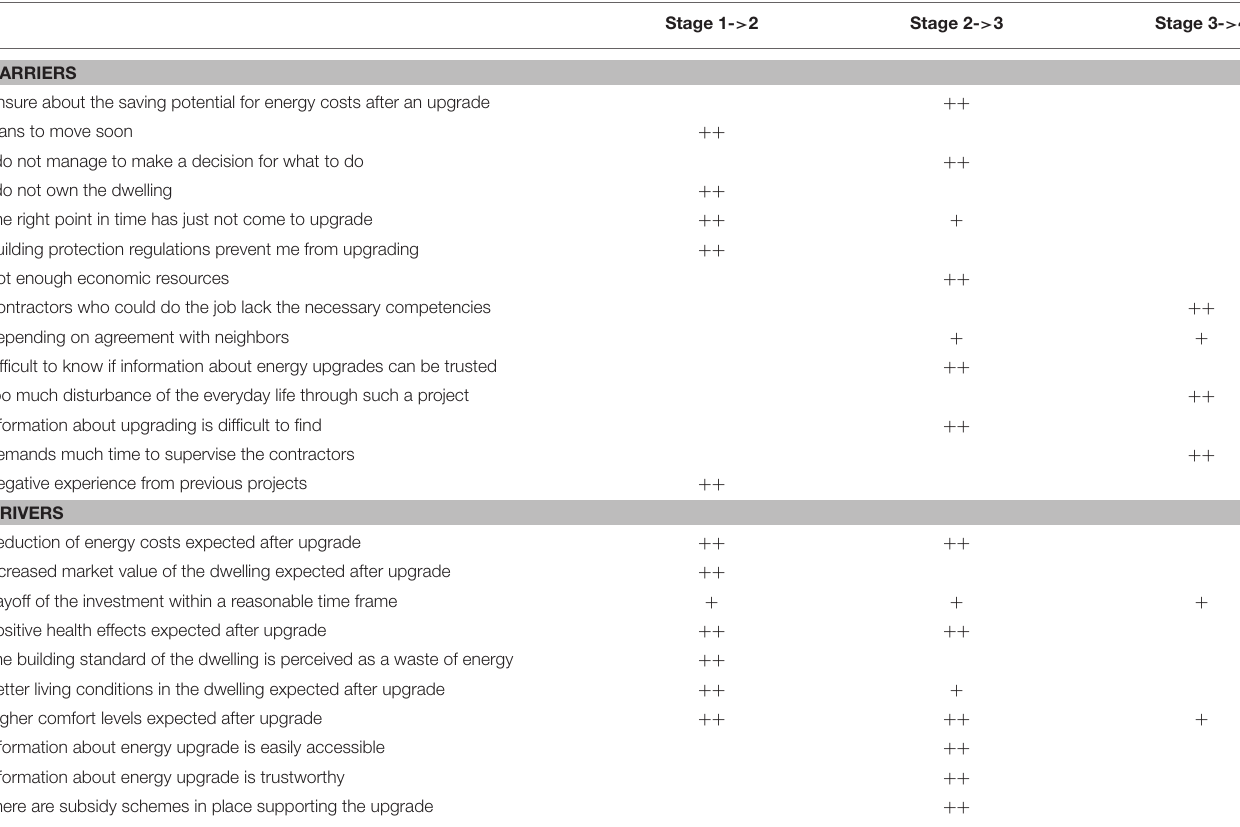
TABLE 1 | Hypotheses about the stage-specific relevance of the tested barriers and